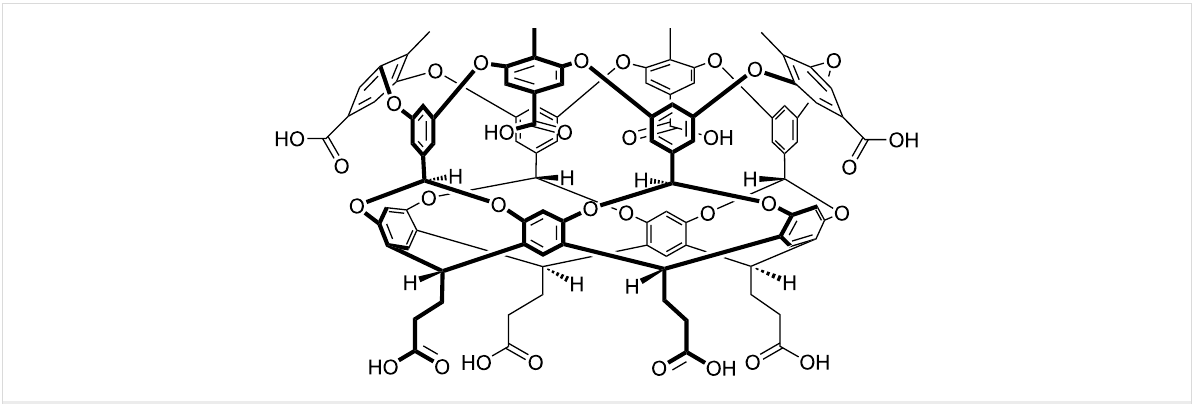
Figure 13: Structure of tetra- endo -methyl octa-acid (TEMOA).